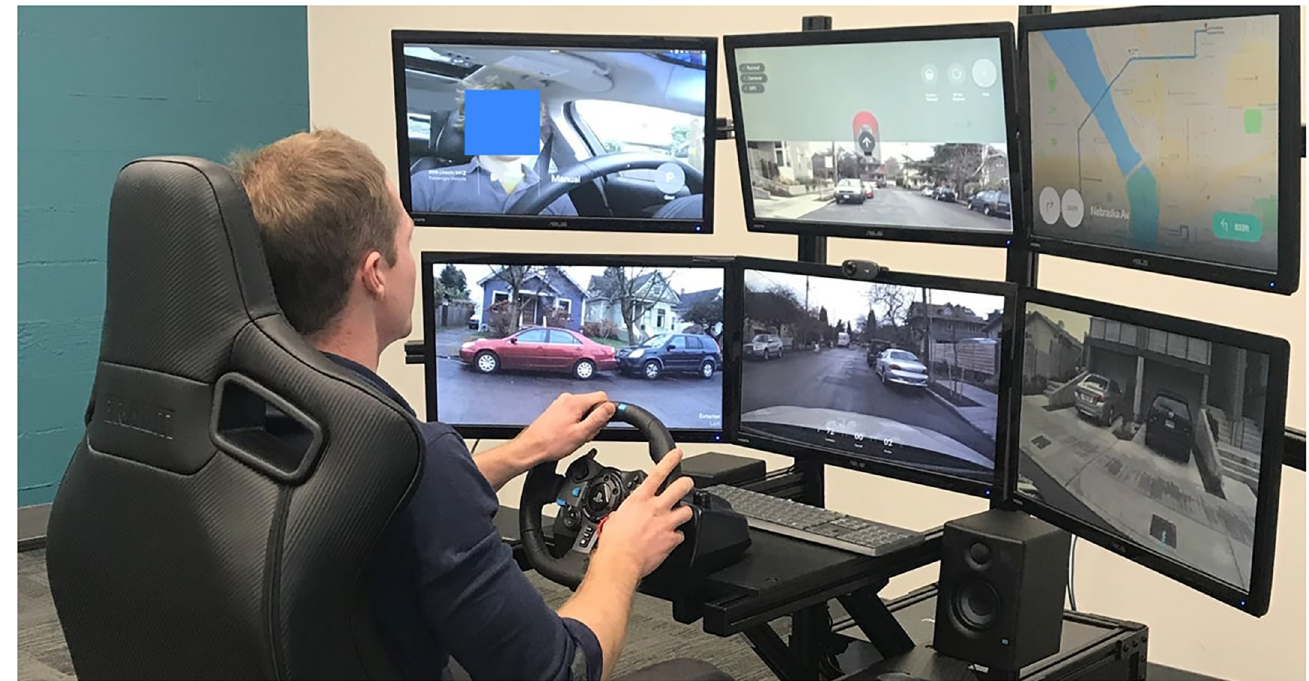
Fig 1. Teleoperations platform by the startup Designated Driver (https://designateddriver.ai/).